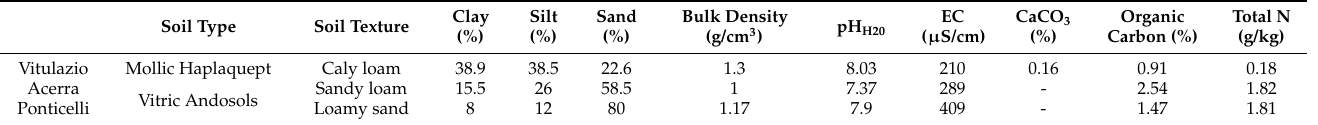
Table 4. Soil properties at 0–0.20 m depth at the three experimental sites.